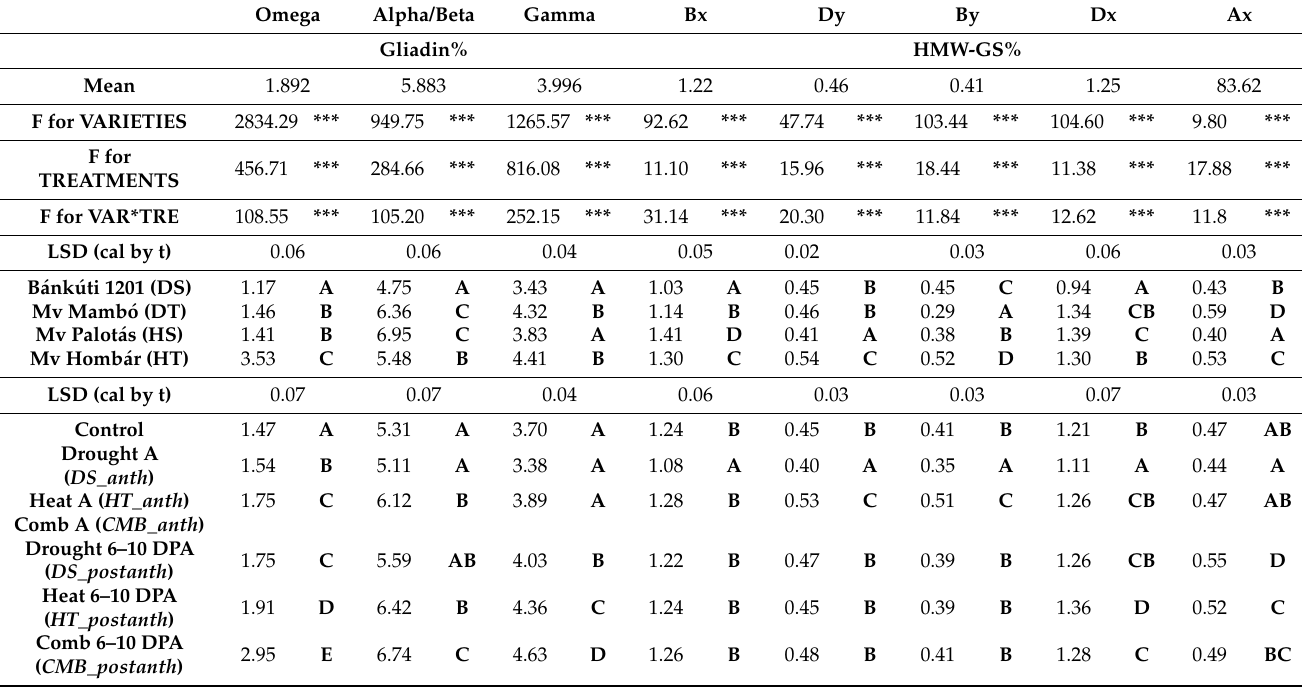
Table 3. The alteration of protein composition caused by the different abiotic conditions based on the RP-HPLC